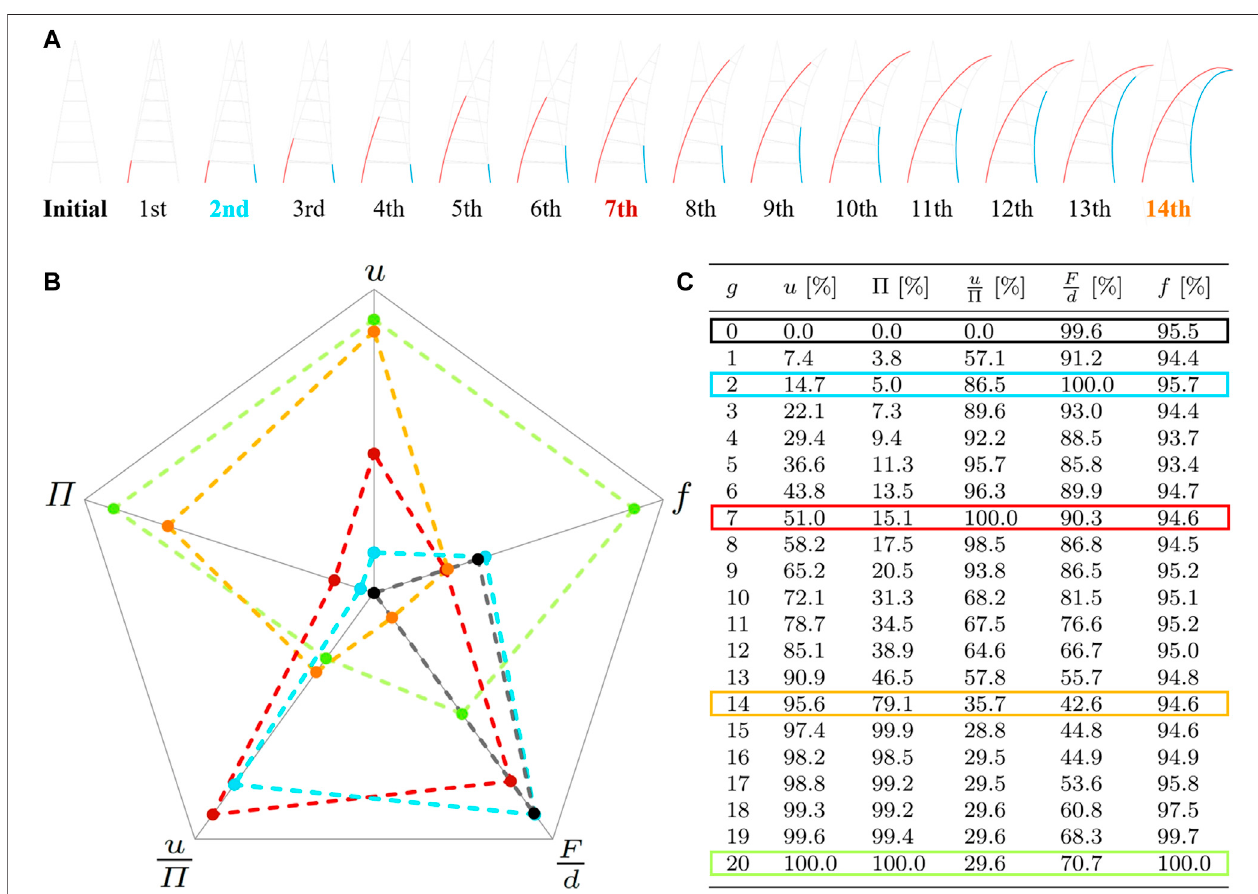
FIGURE 10 | (A) Stepwise process of choice for the placement of 14 actuators by operator χ , observed criteria values for transformation u , energy Π , ef fi ciency u Π , stiffness F , and eigenfrequency f in (B) net-diagram and in (C) the corresponding percentage result values. d